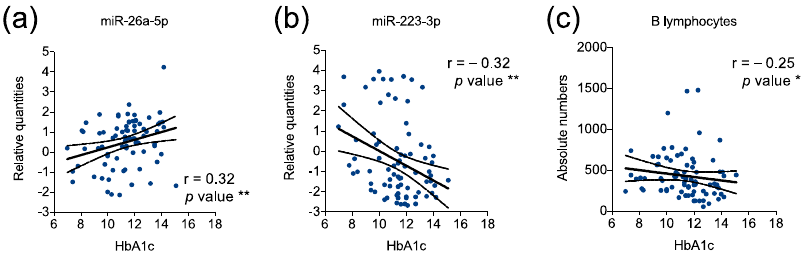
Figure 3. Statistically significant correlations of miRNAs and immune cells with Hb1Ac in children with T1D at diagnosis. Scatter plots showing the one-to-one correlations between relative quantities of the indicated plasmatic miRNAs (a,b) and absolute number/mm 3 of volume for peripheral blood circulating B lymphocytes (c) with the percentage of glycated hemoglobin (HbA1c) in T1D children at diagnosis. Spearman r values and p values are also reported. * p < 0.05, ** p < 0.01. Numbers of children = 80 (a), 81 (b), and 88 (c).